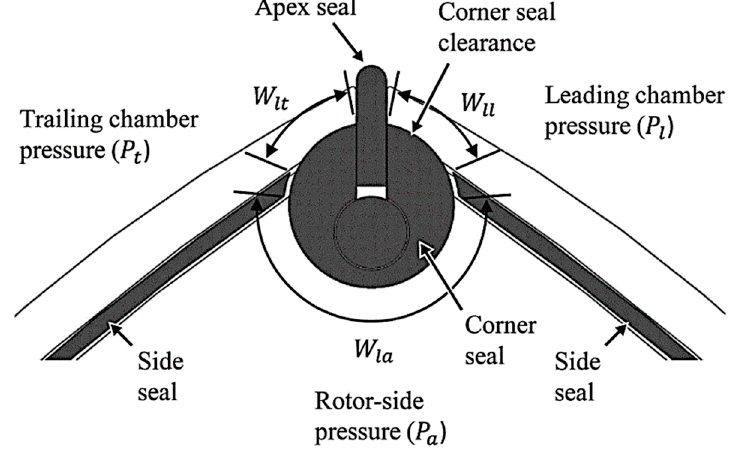
Figure 6. Schematic diagram of corner seal (Picard et al. [69]). The major leakages among all these types are the leakages at the spark plug cavity and the corner seal gap. In his research, Picard reported that the leakages at the spark plug cavities and the corner seal are nearly 29% and 28% (refer to Figure 7) of the total leakage [70].